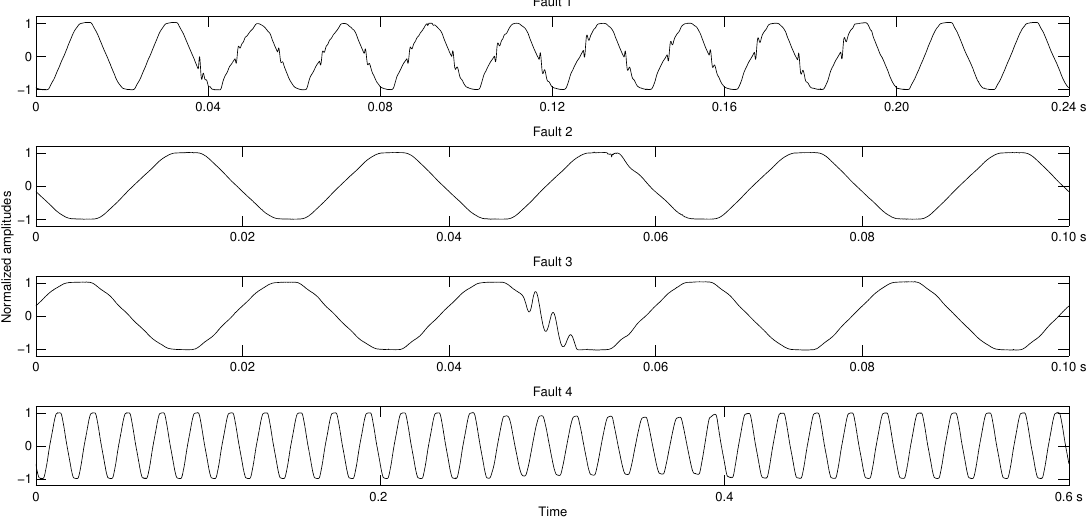
Figure 2. The four types of faulty signals under test. Fault #1: Harmonics. Fault #2: Impulsive transient (Dirac delta). Fault #3: Oscillatory transient (700 Hz). Fault #4: A voltage sag characterized by a duration of 0.15